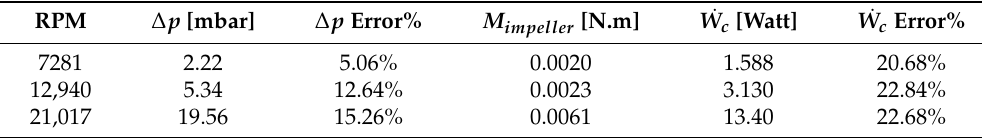
Table 9. ORP numerical model comparison with different experimental